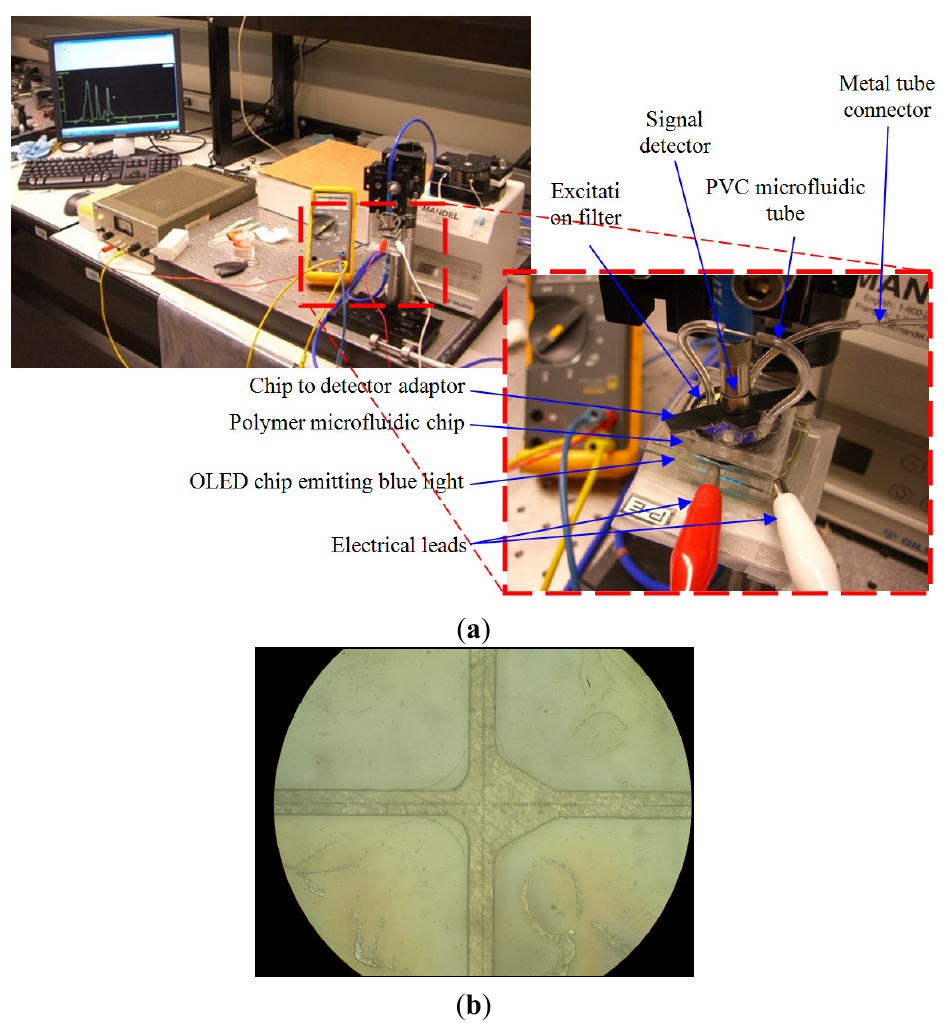
Figure 9. ( a ) Schematic of bio-optical fluorescence detection setup using OLED source. ( b ) ( b ) Close up of Triangular Close up of Triangular Chamber.